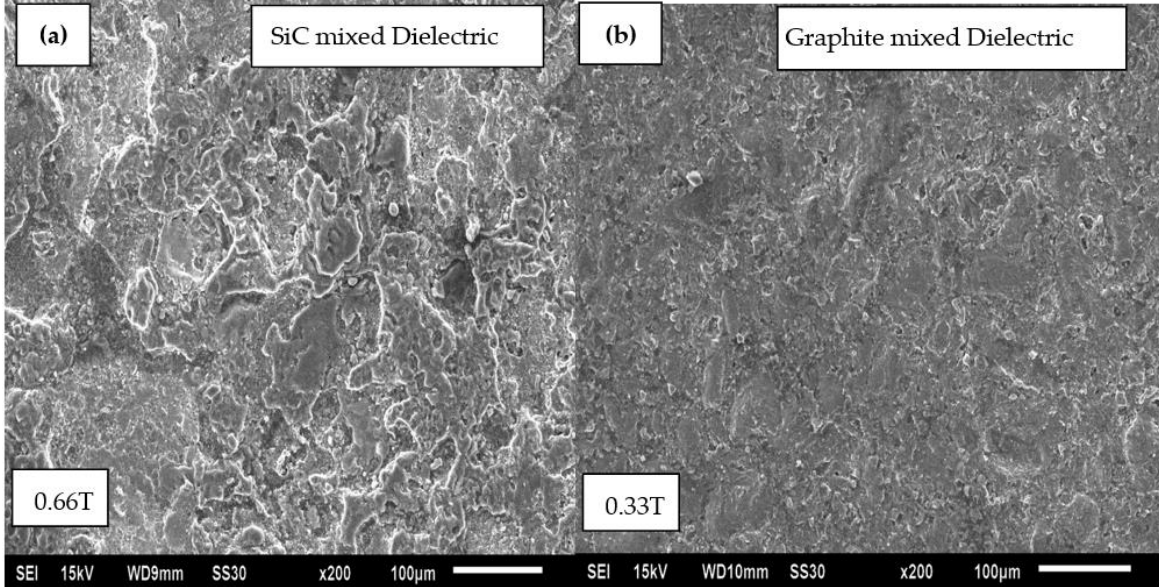
Figure 10. SEM analysis for comparative surface texture of various machined samples. ( a ) SiC mixed dielectric at 0.66T ( b ) Graphite mixed dielectric 0.33T.